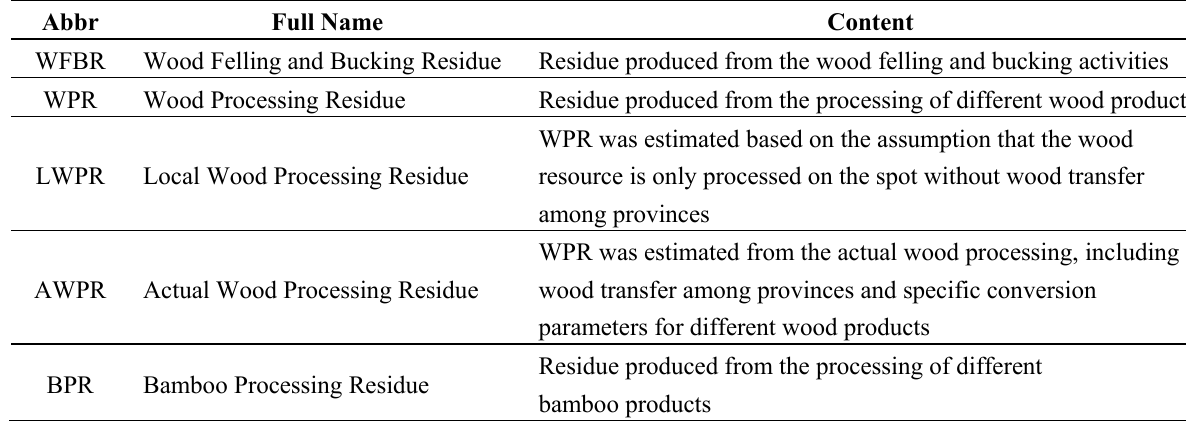
Table 1. Abbreviations used in the